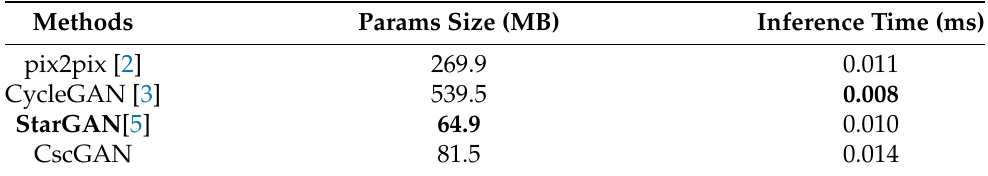
Table 5. The total parameter sizes and inference time of the different methods. Note that the best results are highlighted in